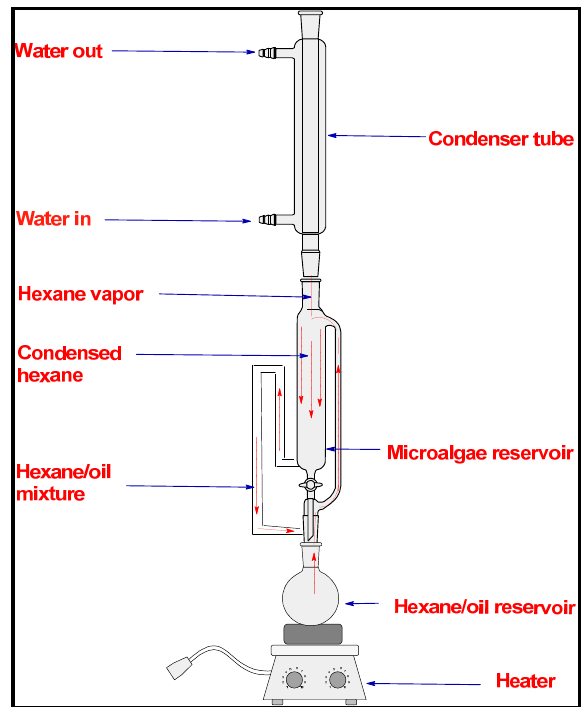
Figure 1. Scheme of the soxhlet extractor used to extract the crude oil from Chlorella vulgaris microalgae powder.